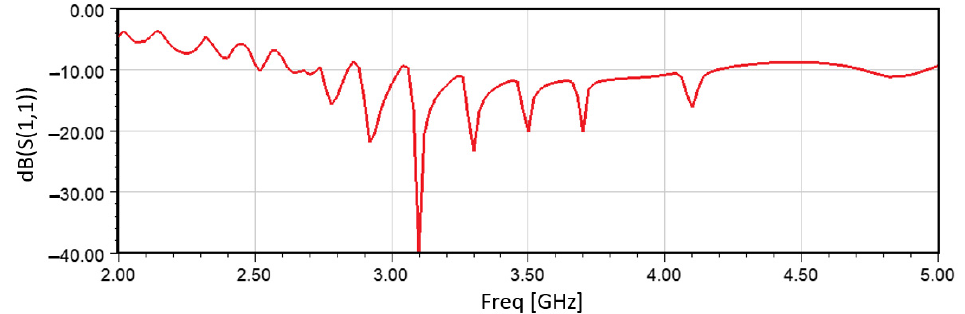
Figure 3. Reflection coefficient (S 11 ) of the proposed antenna 1.